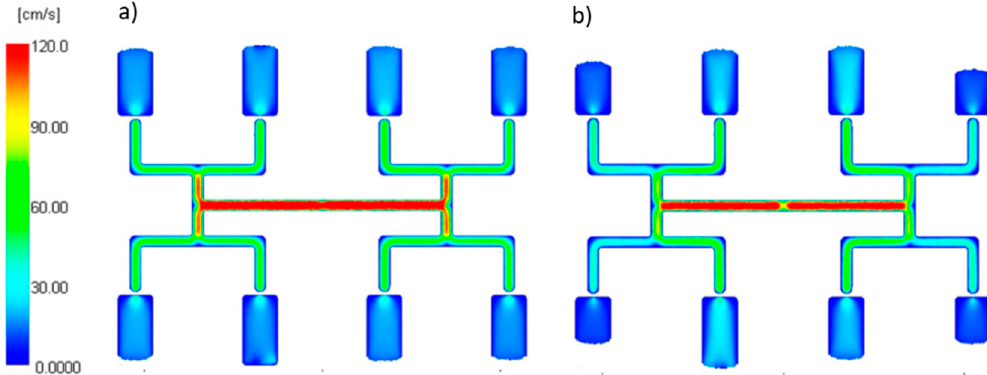
Figure 12. Velocity distribution for different zero shear viscosity at high injection rate: ( a ) η 0 = 153 Pa · s, ( b ) η 0 = 24,366 Pa · s.